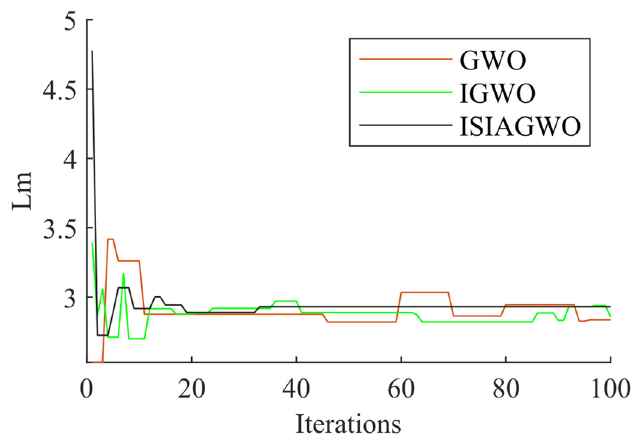
Figure 17. The stator ‐ rotor mutual inductance of DFIG identification convergence curve.